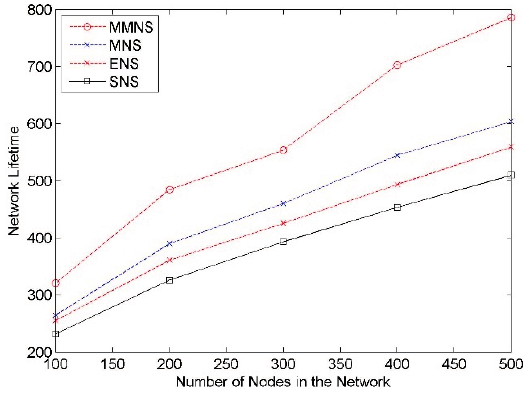
Figure 8. The impact of the network size on the network